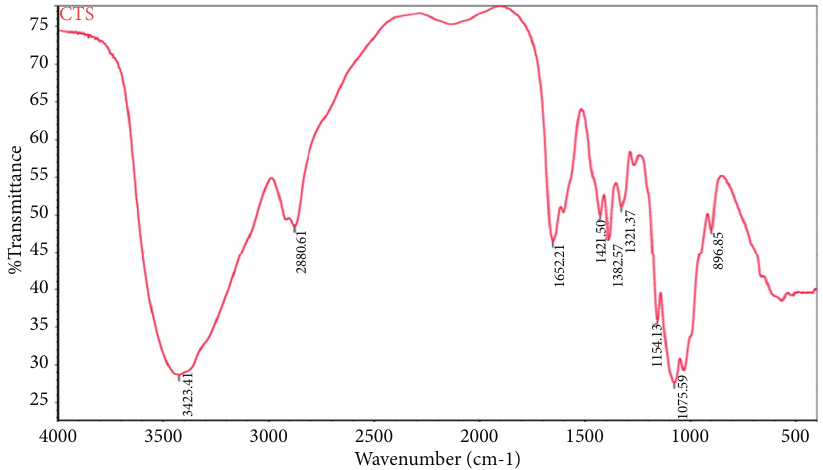
Figure 4: Infrared spectrum of the original chitosan sample.